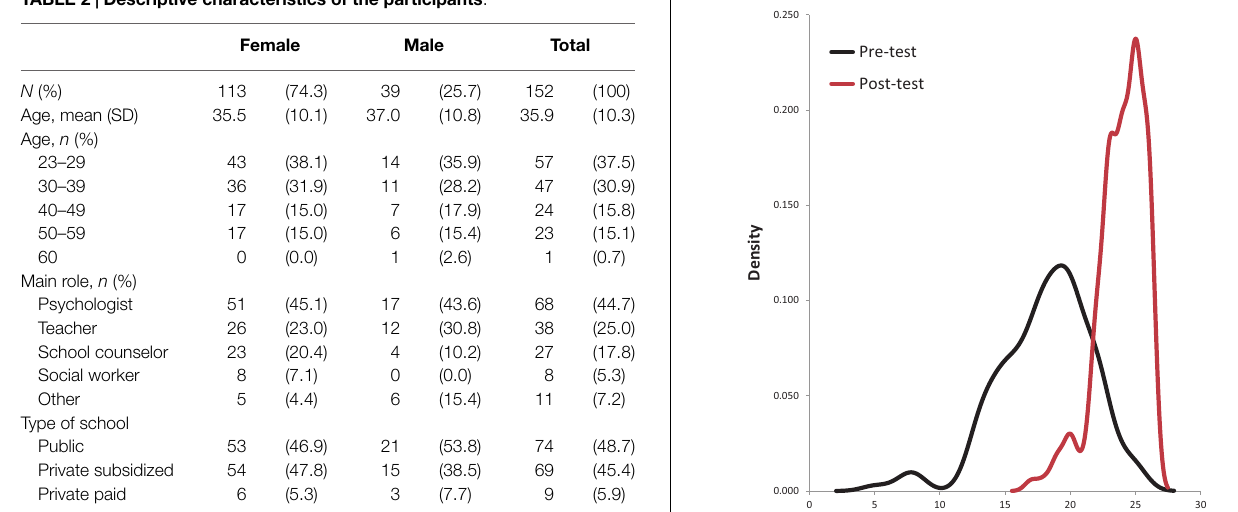
TABLE 2 | Descriptive characteristics of the participants .